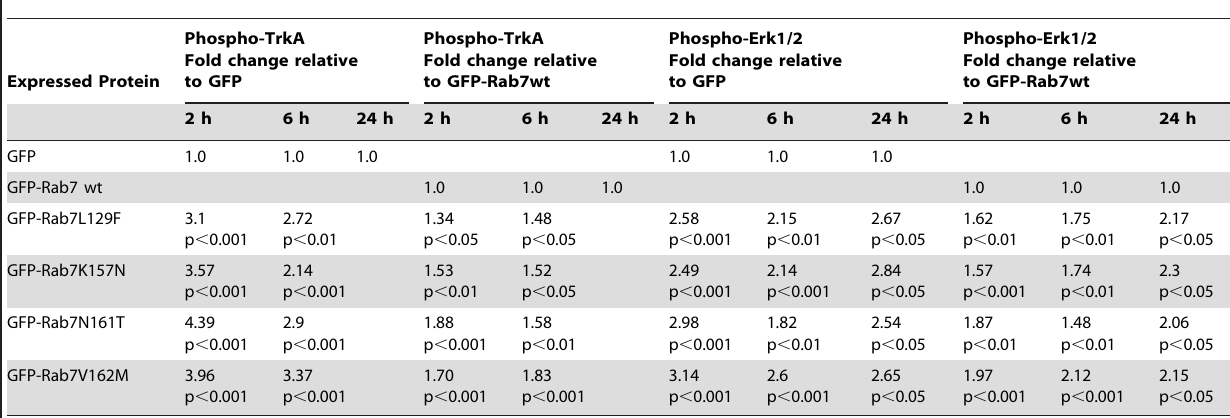
Table 1. Fold-changes in phospho-TrkA and phospho- Erk1/2 due to Rab7 CMT2B mutants.